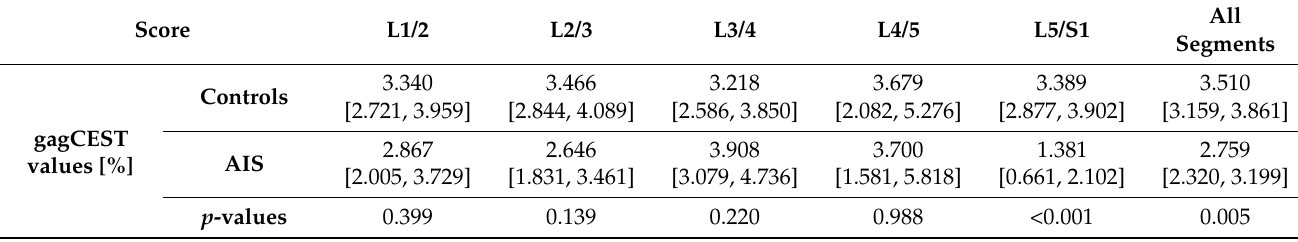
Table 3. Analysis of compositional imaging features of lumbar intervertebral discs (IVDs).